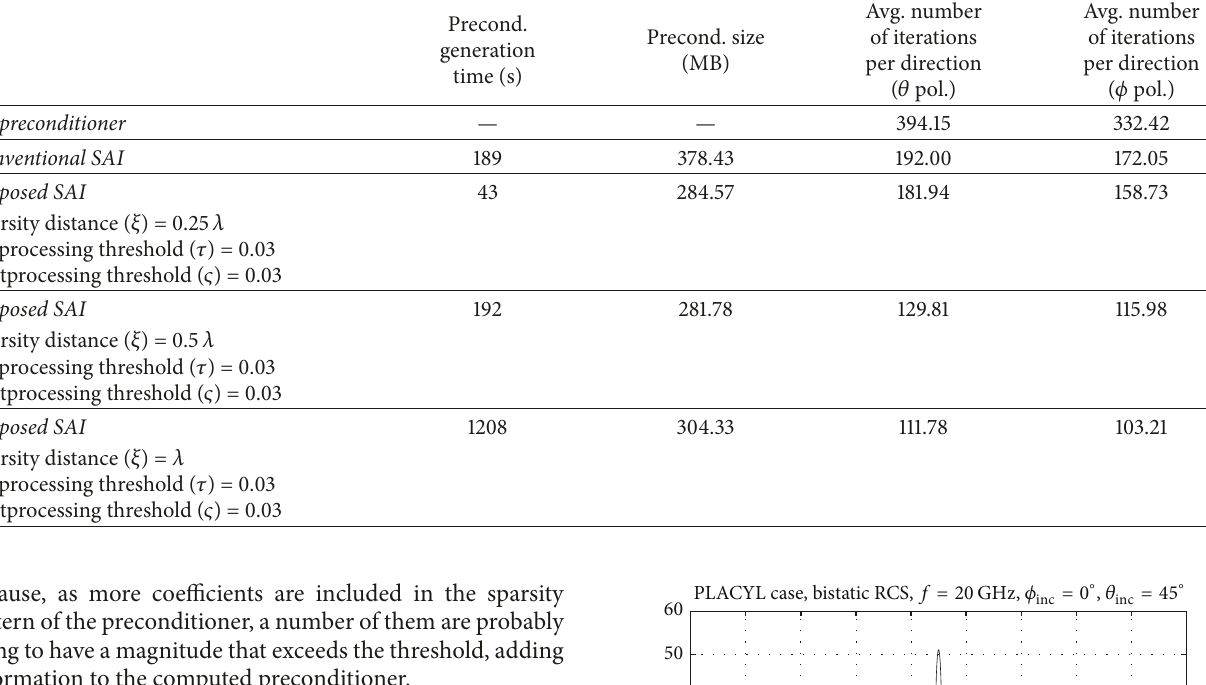
Table 1: Convergence performance for several SAI parameters.